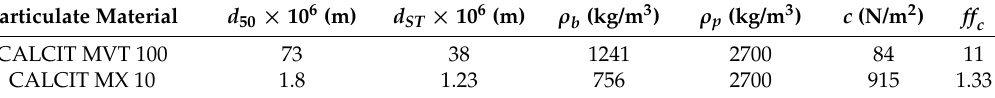
Table 2. Properties of powders used in this study.